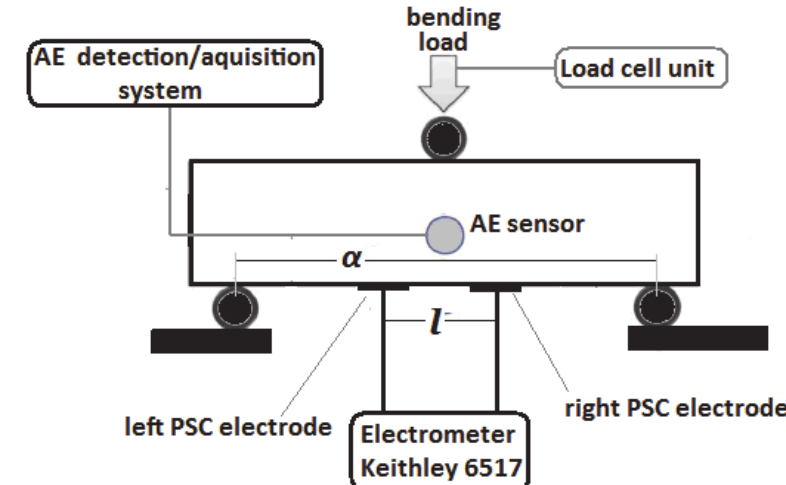
Figure 1: The experimental installation and the location of the AE and PSC sensors.